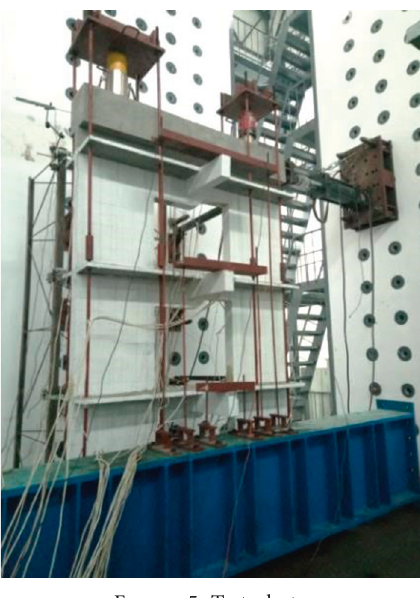
Figure 5: Test photo.